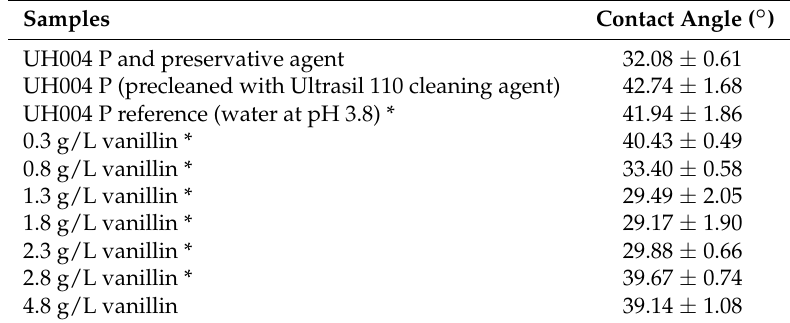
Table 4. The effect of precleaning with Ultrasil 110 cleaning agent and vanillin adsorption on the contact angle of UH004 P membranes (error is based on 95%